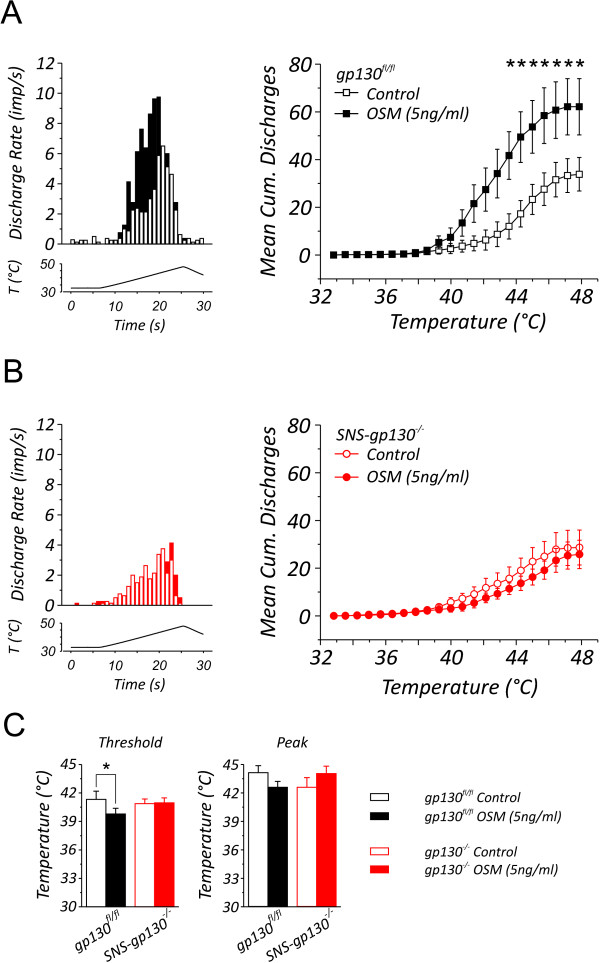
Discharge characteristics of heat-sensitive C-fibers innervating the dorsal site of the hindpaw recorded in an in vitro skin-nerve preparation from gp130fl/fl and SNS-gp130-/- mice upon a heat-ramp stimulus. (A) Left panel; the discharge pattern of gp130fl/fl C-fibers is changed upon stimulation with 5 ng/ml OSM, the amount of discharges recorded is increased and has shifted to lower temperatures. The mean cumulative discharge rates in heat-sensitive C-fibers from gp130fl/fl were significantly higher after perfusion with 5 ng/ml OSM (filled squares, n = 8) compared with rate of discharge before OSM application (open squares, n = 8). (B) However, in SNS-gp130-/- C-fibers, the discharge pattern evoked by a heat ramp stimulus is unaltered after stimulation with OSM (left panel). Furthermore, OSM perfusion failed to increase the mean cumulative discharge rate of heat-sensitive fibers in SNS-gp130-/- skin-nerve preparations (control; open circles, +OSM; filled circles, n = 8). (C) The discharge threshold temperature of gp130fl/fl (n = 8,) is significantly decreased after stimulation with OSM (5 ng/ml), whereas in SNS-gp130-/- the threshold temperature remained unchanged (left bar graph, n = 8). The temperature at which the maximal discharge rate was achieved was unaltered in both gp130fl/fl and SNS-gp130-/- (right bar graph, n = 8). * p < 0.05, Wilcoxon signed rank test.